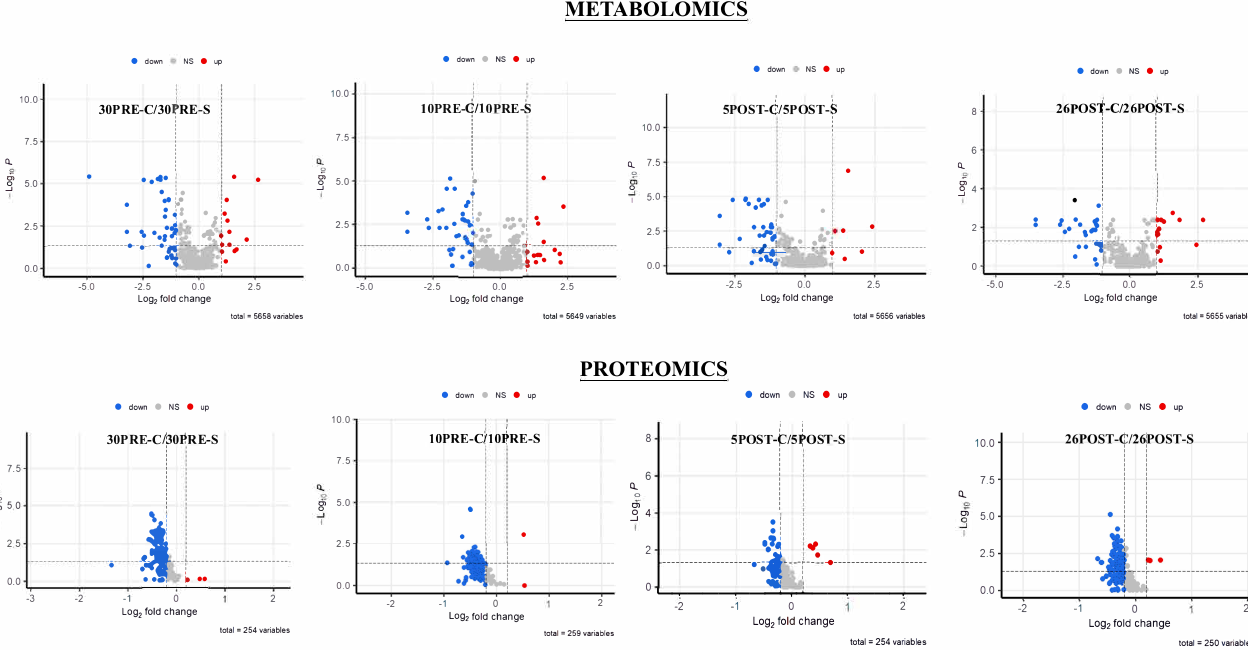
Figure 3. Distribution of differential expression of metabolites and proteins across group comparisons. Volcano plot showing the distribution of significant metabolite features and proteins based on t-tests versus fold change in 30pre-S vs. 30pre-C, 10pre-S vs. 10pre-C, 5post-S vs. 5post-C, and 26post-S vs.